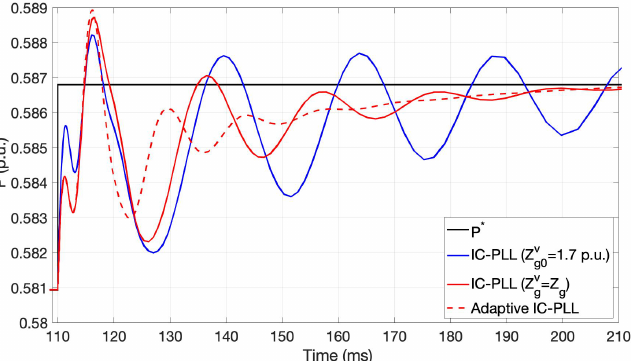
Figure 12. Time-domain response of the active power for different types of PLLs for step change in active power and for ω FL , PLL = 400 rad/s, Z g = 2 p.u. (inverter operation).